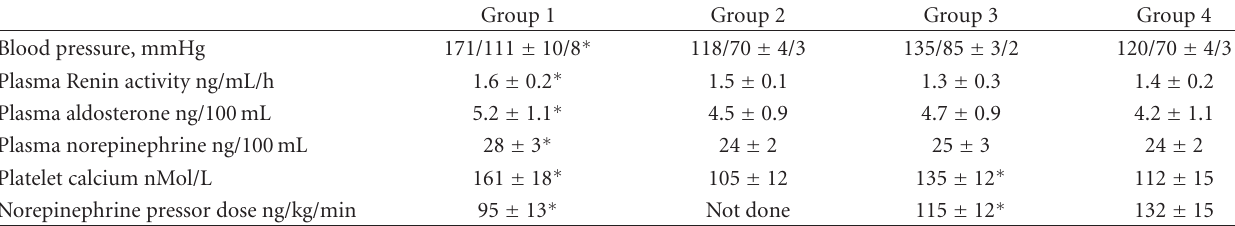
Table 2: Blood pressure, pressor hormones, cytosolic calcium and cardiovascular reactivity to norepinephrine in PHPT patients and age and sex matched normotensive